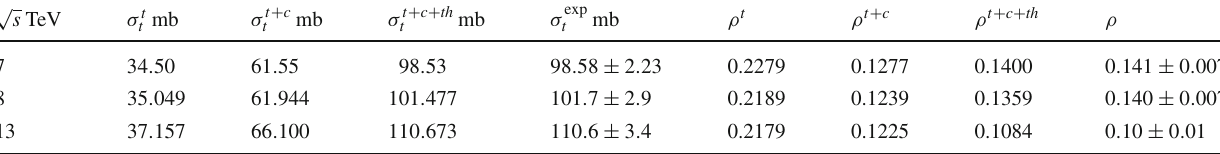
Table2 Totalcrosssectionwith(two-quarkforce, σ t t ),with(two-quark force +pion cloud, σ t + c t ) and with (two-quark force +pion cloud+three- quark force, σ t + c + th t